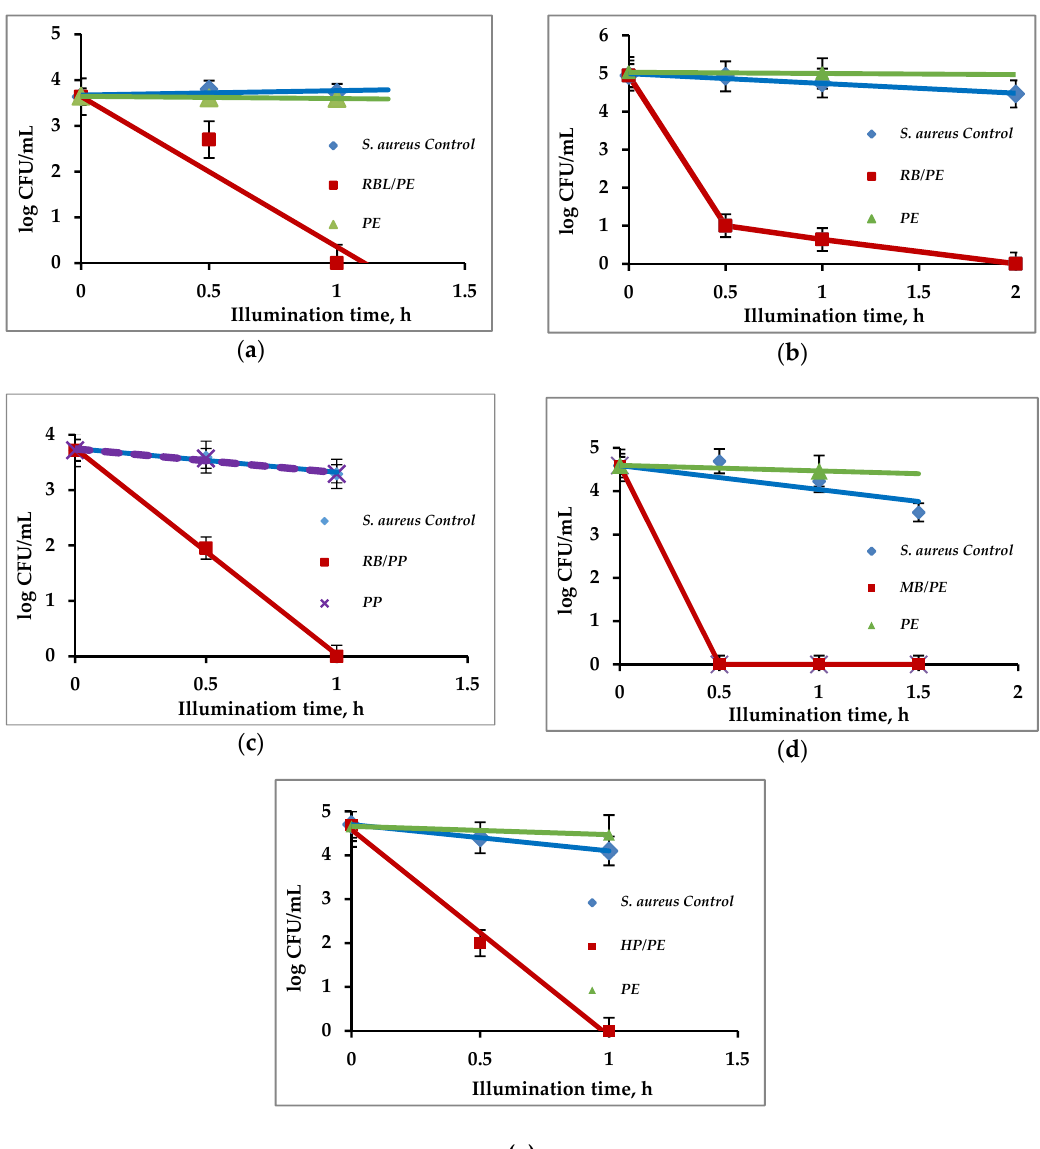
Figure 3. Effect of PSs immobilized onto polymers on the concentration of S. aureus under illumination with 1.25 mW/cm 2 white light. ( a ) 1% RBL/PE at a 4 g/L loading; ( b ) 1% RB/PE at a 20 g/L loading; ( c ) 1% RB/PP at a 320 g/L loading; ( d ) 1% MB/PE at a 220 g/L loading; ( e ) 1% HP/PE at a 10 g/L loading. Control experiments— S. aureus in the absence of any polymer and in the presence of PE or PP.